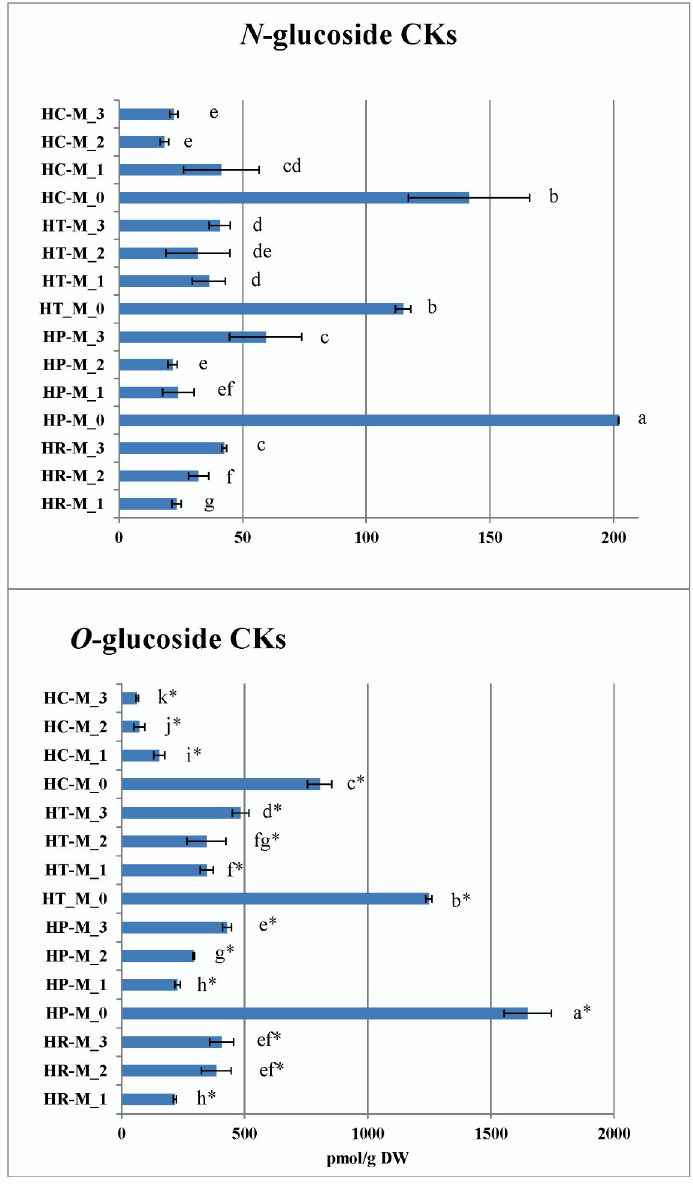
Figure 10. Total sum of cytokinin N- and O-glucosides (upper and lower figure, respectively) in the four Hypericum species in M_0—PGR-free, M_1—0.2 mg/L BA, M_2—0.2 mg/L BA + 0.1 mg/L IBA and M_3—0.1 mg/L BA + 0.2 mg/L IBA supplemented media, HR– H. richeri Vill., HP– H. perforatum L., HT– H. tetrapterum Fries. and HC– H. calycinum . Same letters indicate statistically